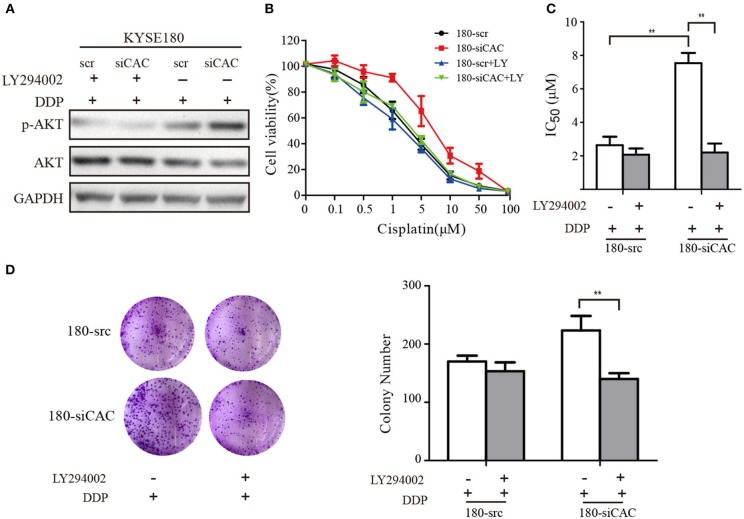
LY294002 restores the sensitivity of ESCC to cisplatin in CACNA2D3-knockdown cells. (A) CACNA2D3-knockdown KYSE180 cells and control cells were treated with cisplatin at the indicated concentrations with or without LY294002 for 72 h. Levels of P-Akt and Akt proteins were analyzed by western blotting. (B) The number of viable cells was measured by CCK-8 assay. (C) IC50 values were calculated using linear or logarithmic regression (R2 > 0.9). Data are presented as the mean ± SD from triplicate wells. (D) Colony forming assays were used to determine the colony forming ability after cisplatin with or without LY294002 treatment. Data are presented as the mean ± SD from three wells. **p < 0.01.